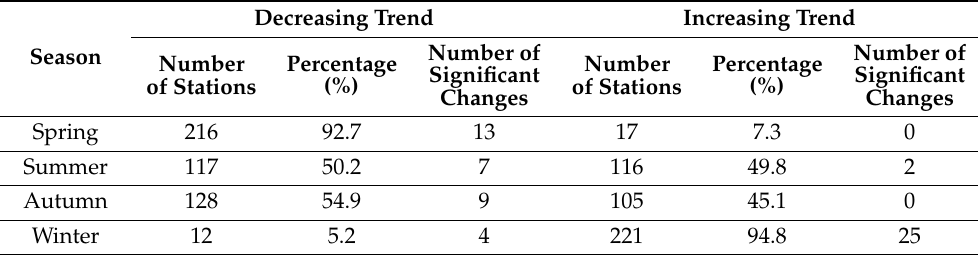
Table 2. Precipitation trends for different seasons in the Huaihe River